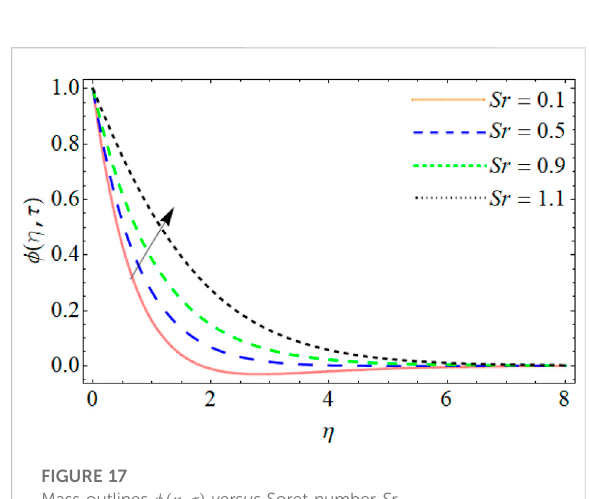
FIGURE 14 Mass outlines ϕ ( η , τ ) versus destructive chemical reaction γ .